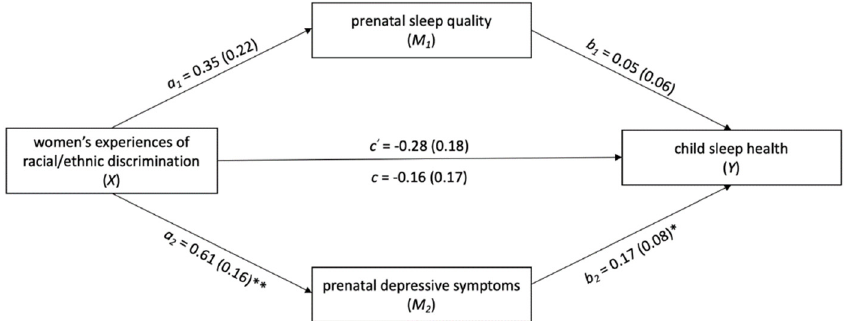
Figure 1. Examining prenatal sleep quality and depressive symptoms as parallel mediators of the